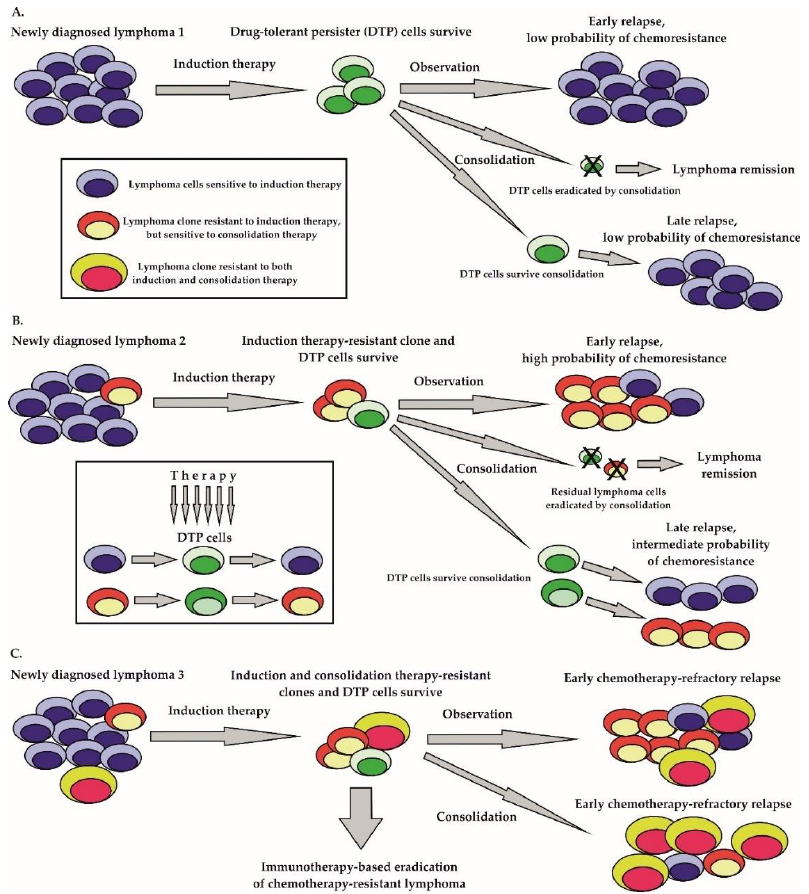
Figure 1. Resistance to therapy. A . Low level of genomic heterogeneity—lymphoma population without preexisting drug-resistant cells. B . Intermediate level of genomic heterogeneity—lymphoma population with the preexisting drug-resistant clone resistant to induction therapy; C . High-level of genomic heterogeneity—lymphoma population with several clones resistant to diverse immunochemotherapy regimens; DTP—drug-tolerant persister cells .